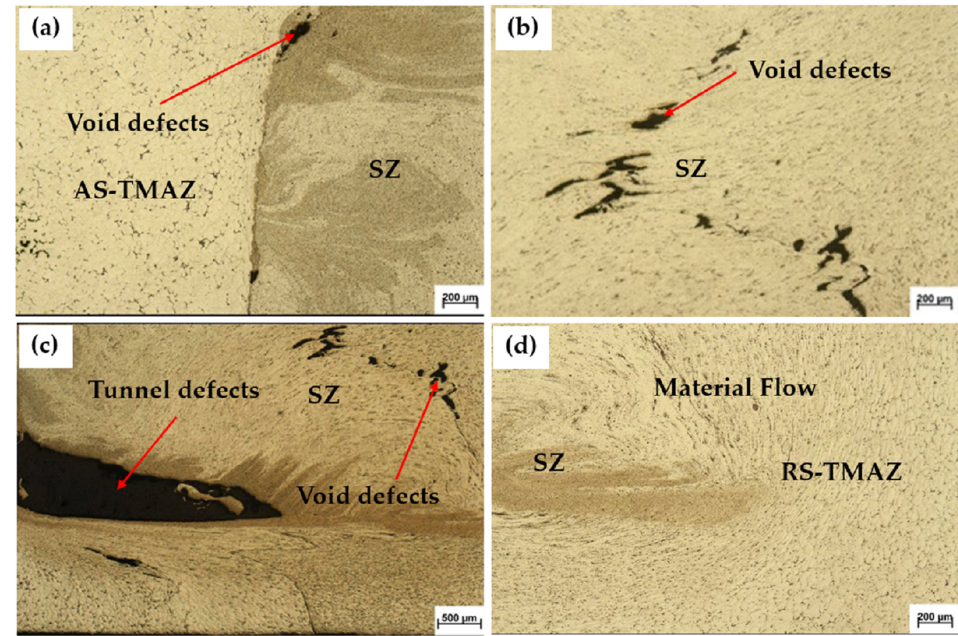
Figure 18. Microstructure of the welded joint at a rotational speed of 1200 rpm, a welding speed of 30 mm/min, and a straight cylindrical tool pin profile: ( a ) AS-TMAZ; ( b ) SZ; ( c ) pin tip on the AS; ( d ) RS-TMAZ.